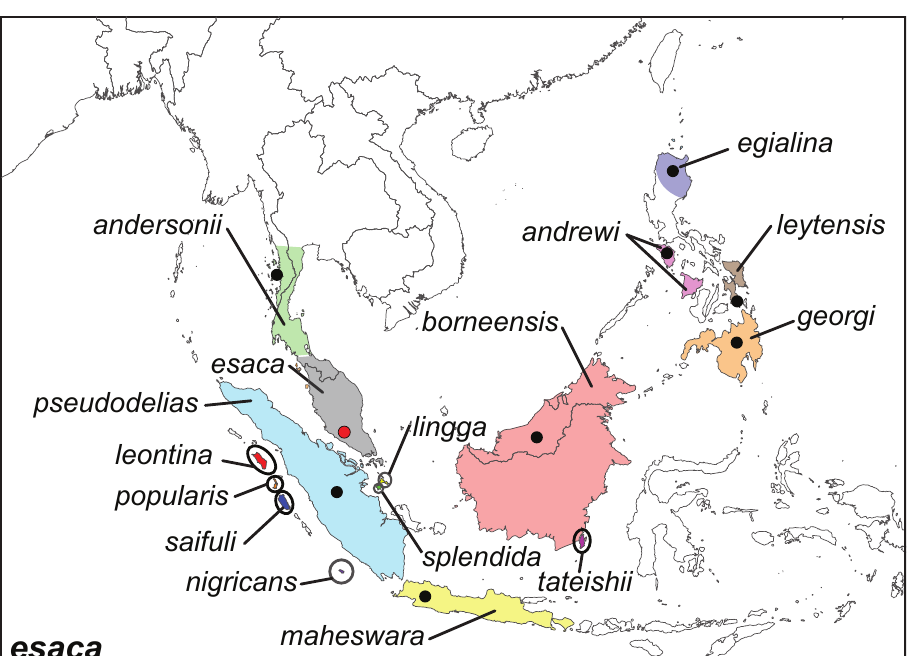
Figure 30. Distribution map of Elymnias